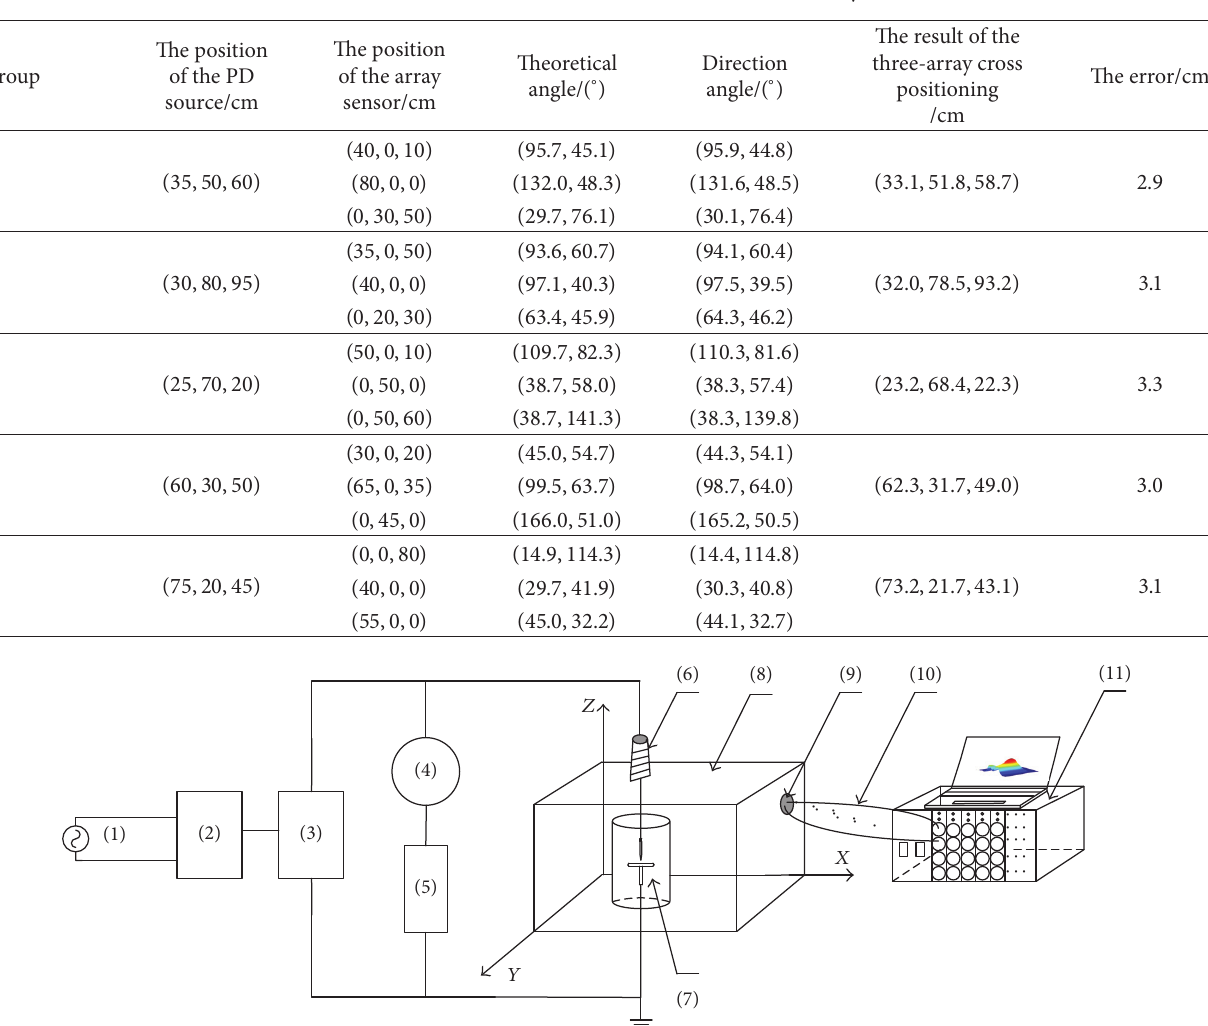
Table 1: The location results of the circular ultrasonic array.